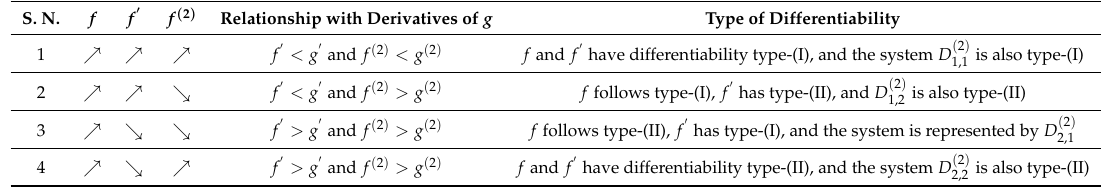
Table 2. Nature of second-order derivatives and their relationship with derivatives of g